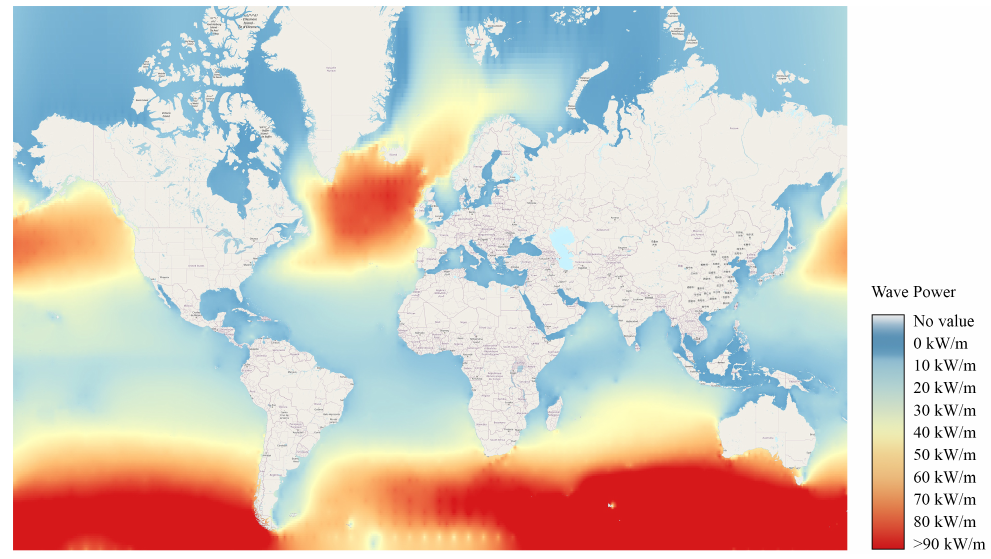
Figure 1. World map of wave power (obtained from